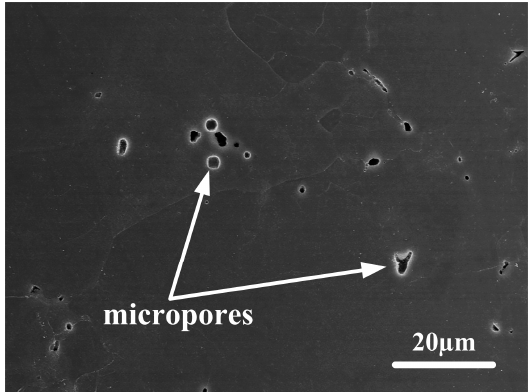
Figure 13. SEM images showing the residual micropores in the microstructure of the PM Ti-5553 alloy.